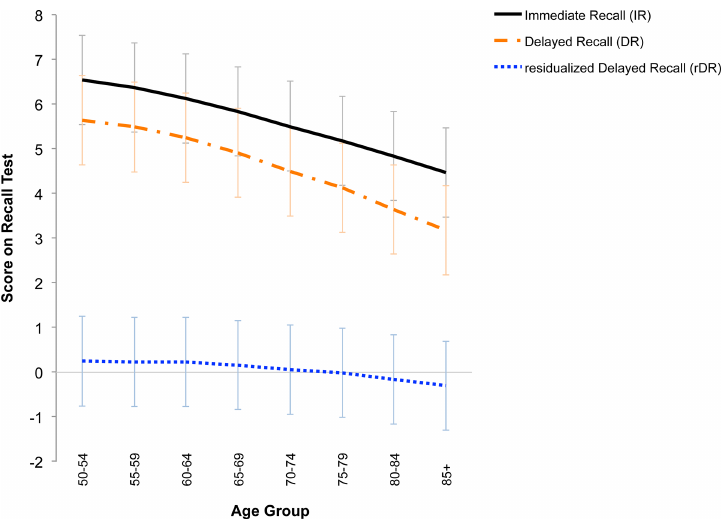
Fig 1. Scores (as words recalled) for immediate, delayed, and residualized delayed recall among 20,650participants in the HRS.